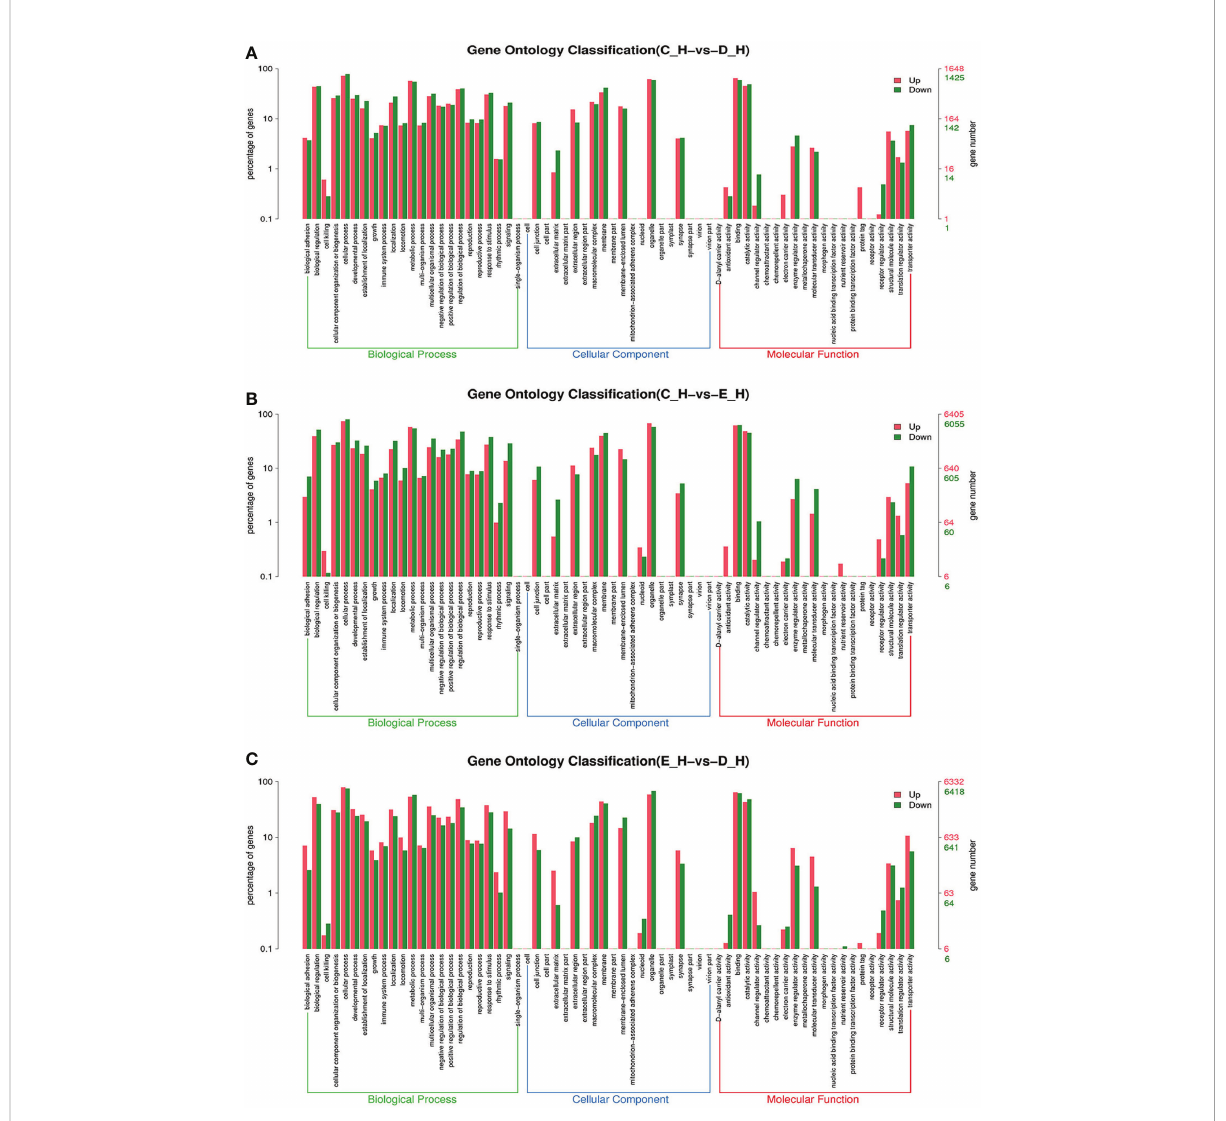
FIGURE 6 GO enrichment analyses of differentially expressed genes (DEGs) in hepatopancreas transcriptome. Notes: (A) Comparison between C-H and D- H; (B) comparison between C-H and E-H. (C) Comparison between E-H and D-H. Notes: (1) C-H: hepatopancreas from inter-molt; D-H: hepatopancreas from per-molt; E-H: hepatopancreas from ecdysis. (2) Red columns indicate GO item entries enriched by upregulated differentially expressed genes, green columns indicate GO item entries enriched by downregulated differentially expressed genes (3) The x -axis shows the item name between two stages, whereas the y -axis represents the number of genes and their percentage of the corresponding